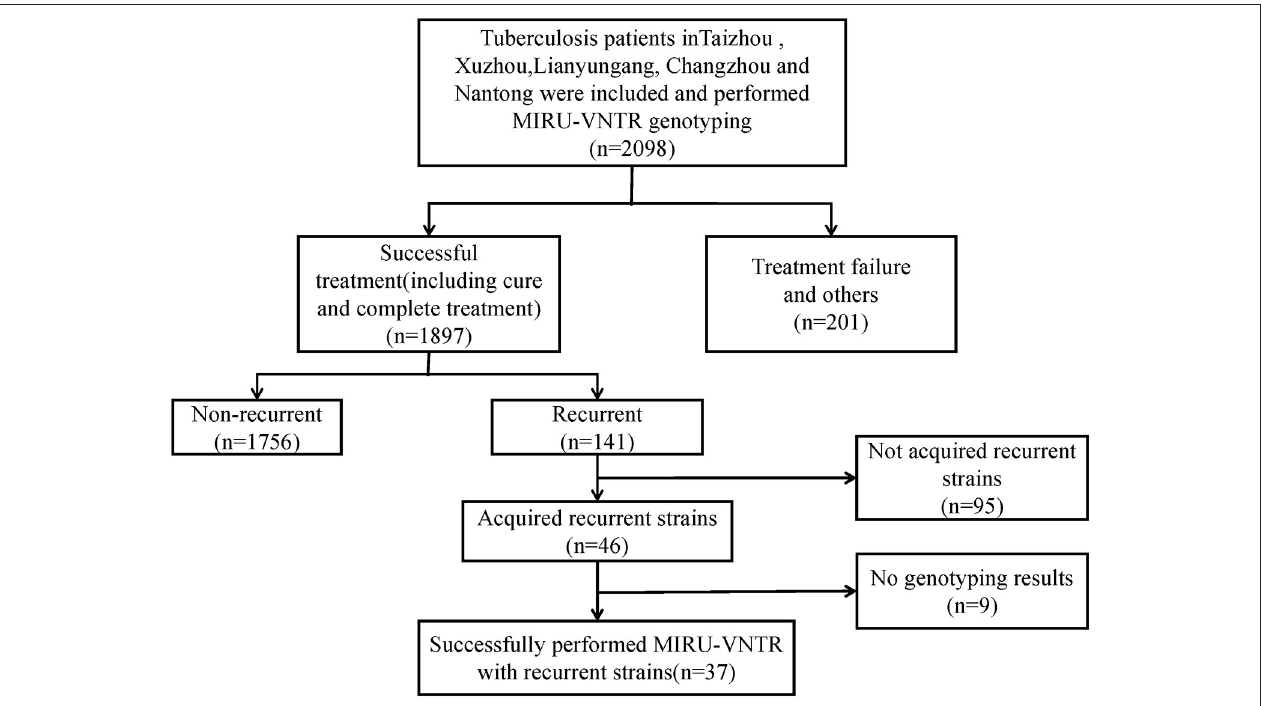
FIGURE 1 | Eligibility and enrollment of included participants. MIRU-VNTR, Mycobacterial Interspersed Repetitive Units-Variable Number of Tandem Repeats; MDR-TB, Multi-drug resistant